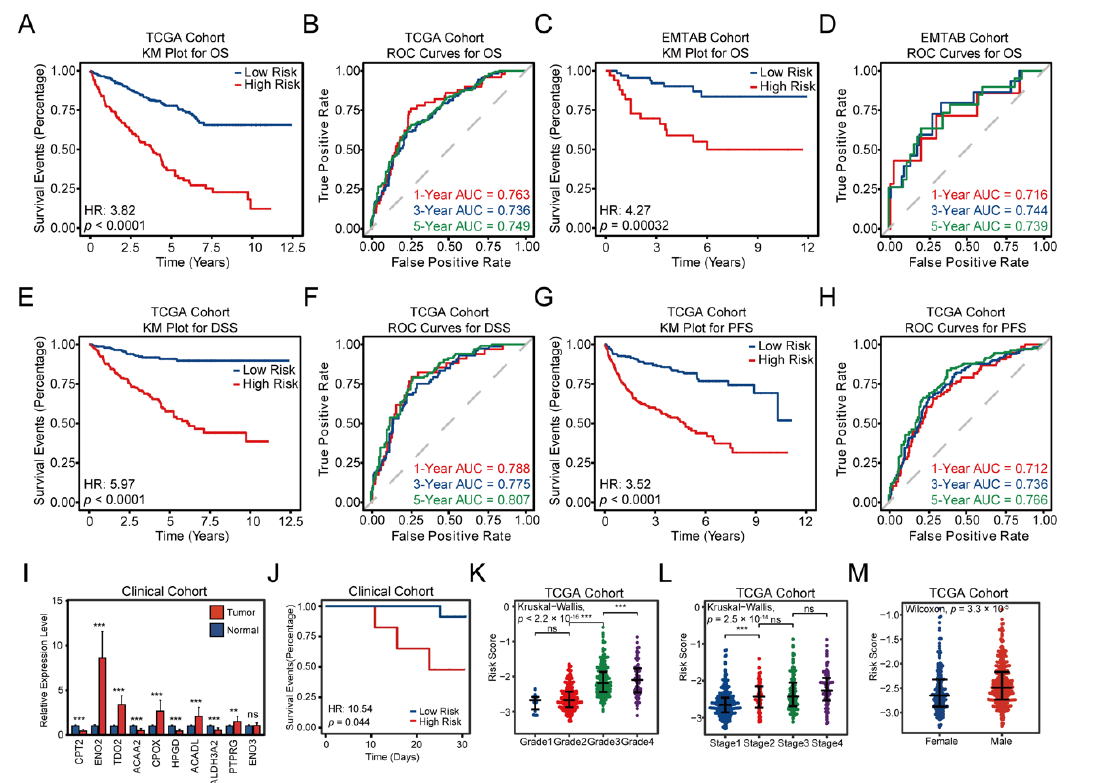
Figure 3. Construction and validation of the fatty acid metabolism-related prognostic signature.